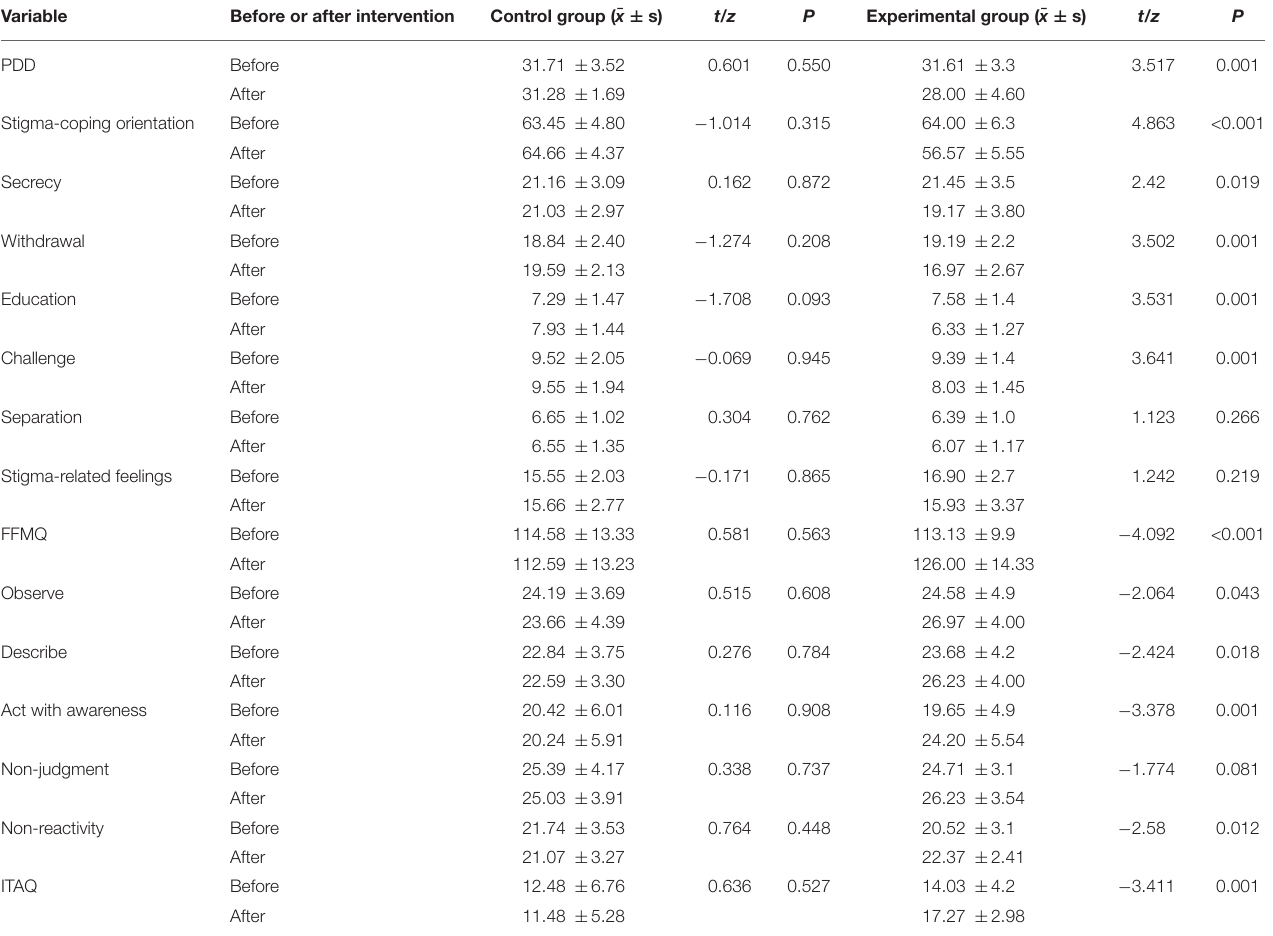
TABLE 5 | Within group comparisons for each group before and after the intervention.